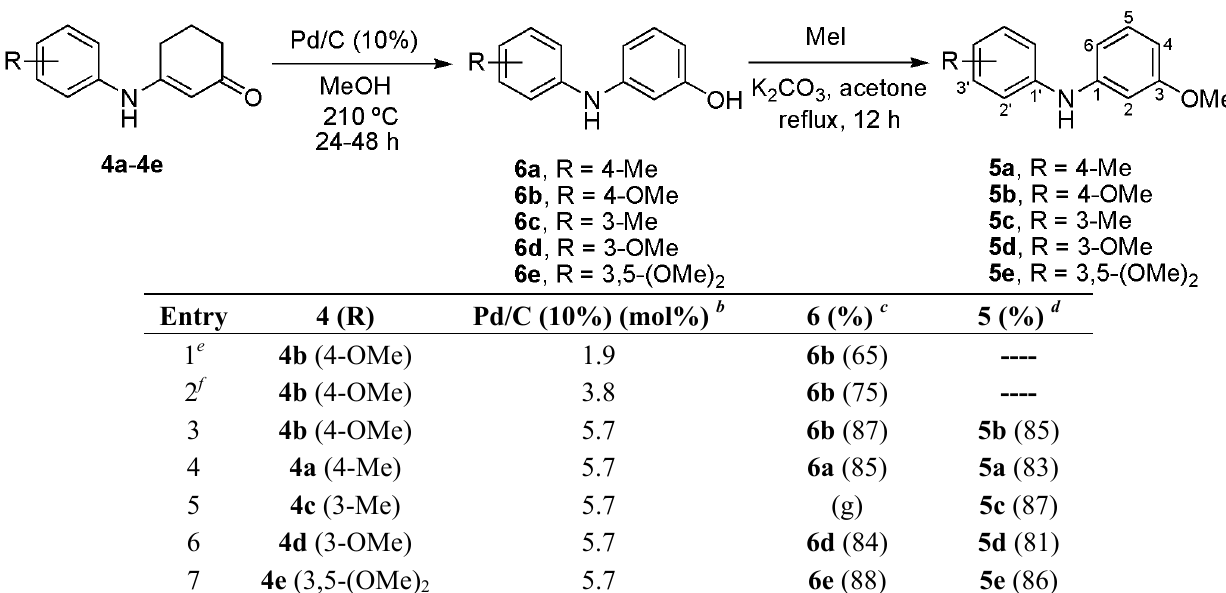
Table 2. Conversion of 3-anilino-2-cyclohexen-1-ones 4a – e into diarylamines 6a – b , 6d – e and 5a – e a .